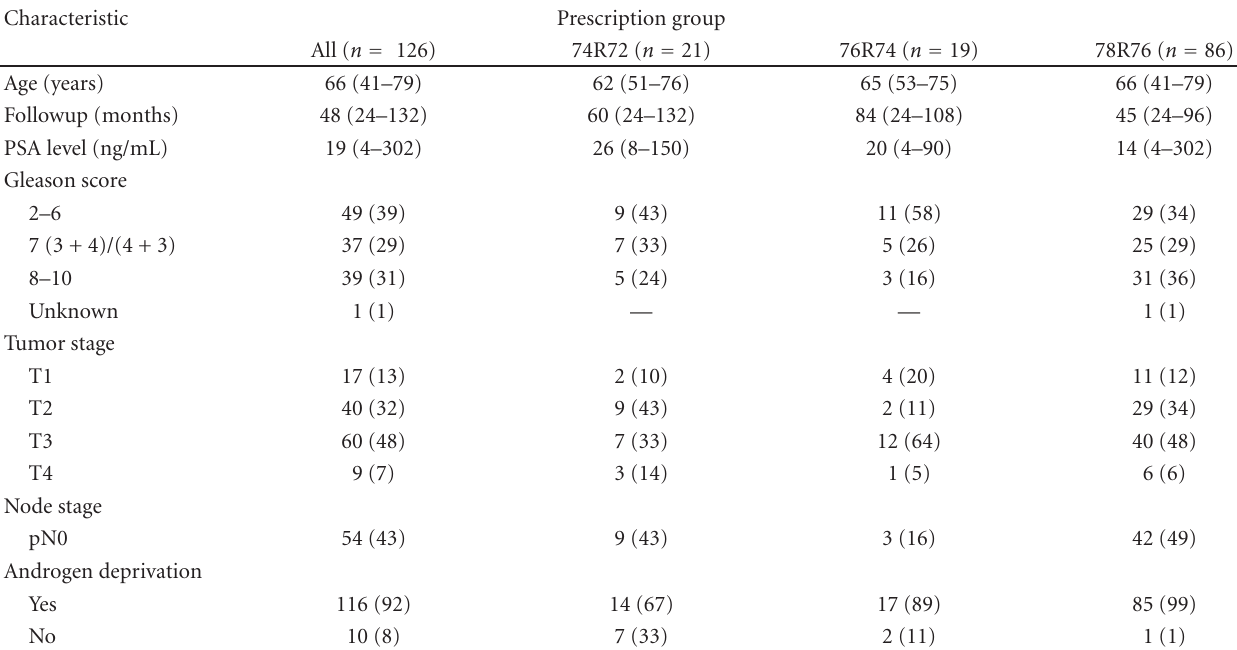
Table 2: Patient’s characteristics for all patients and according to prescription group.